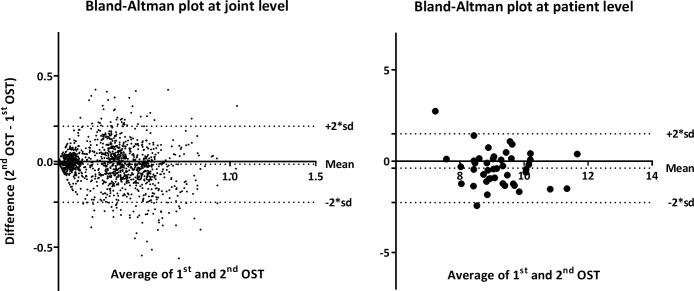
Test-retest agreement of OST.Bland-Altman plots of duplicate OST measurements at patient level (OST index range: 0–66) and at joint level (OST index range: 0–3). 1st OST: first OST measurement, 2nd OST: second OST measurement.